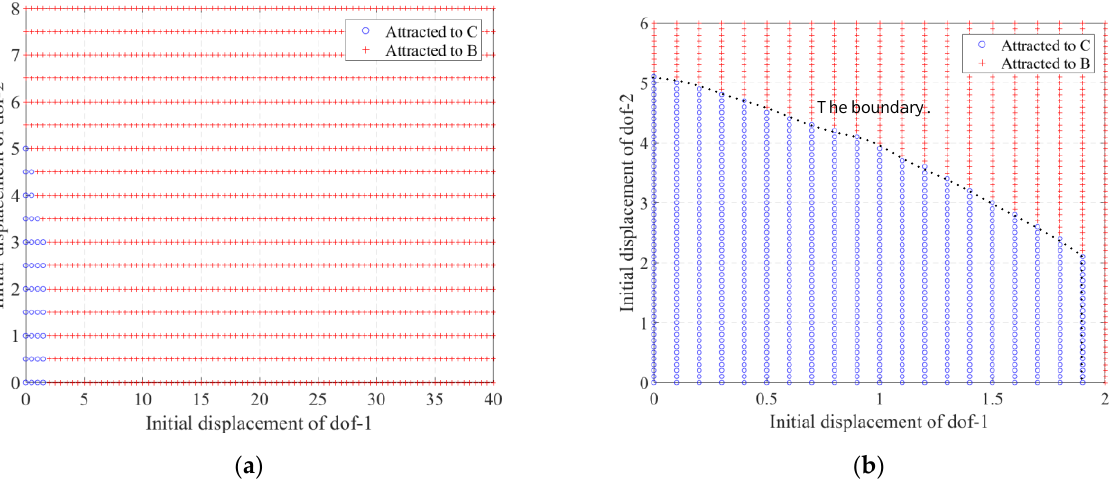
Figure 13. Characteristics of the attraction domain distribution of the two steady-state solutions at an excitation frequency of 1.06: ( a ) overall scope; ( b ) local scope.